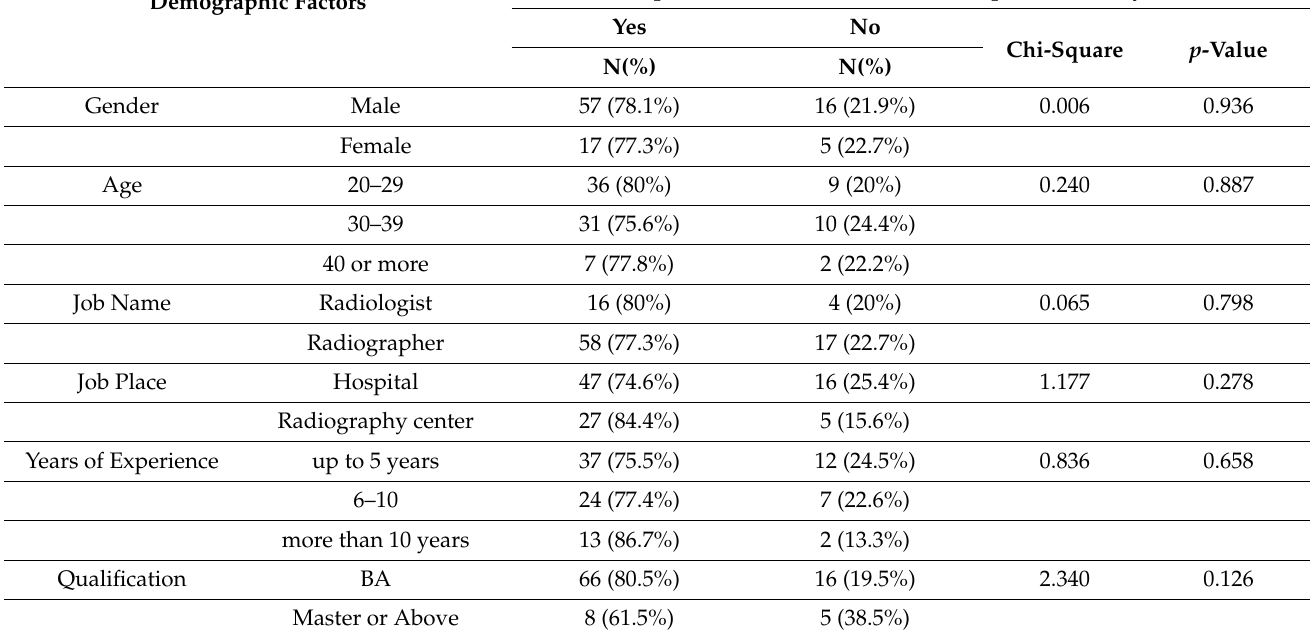
Table 6. Respondents’ attitudes about to what extent the participation of radiologists in diagnosing can be useful, and whether they have sufficient experience and education to participate in this system due to gender, age, job name, job place, years of experience, and